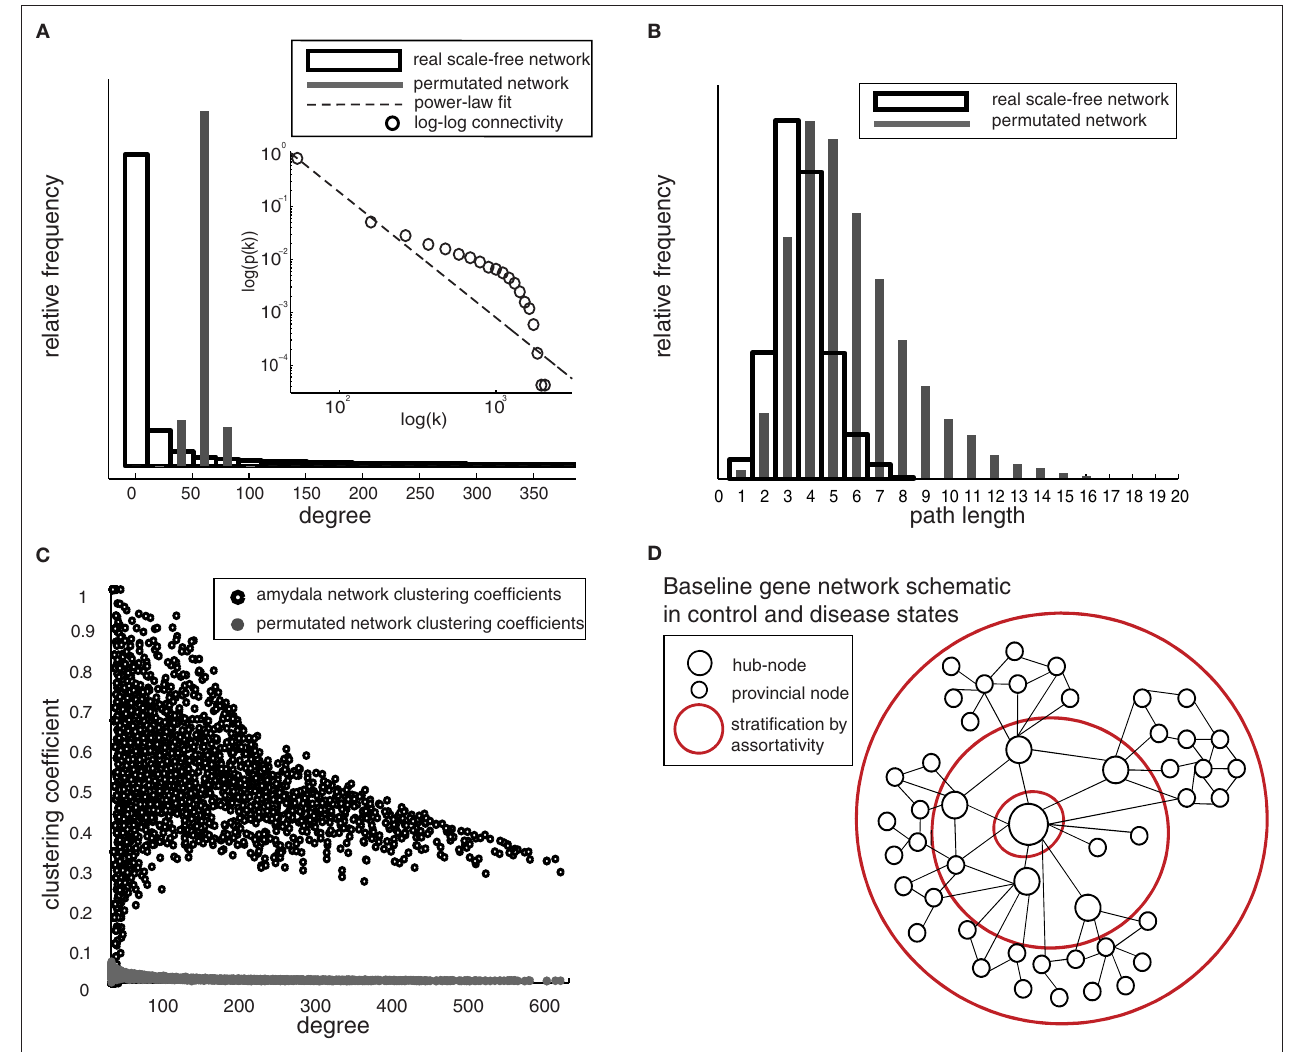
Figure 2 | Scale-free and small-world properties of gene networks common to all human brain datasets – examples from human amygdala. (A) Histogram of frequency of connectivity values for exemplar amygdala network and randomized network with equal total number of links (degree, k), truncated at k = 400 for clarity. Inset: a power-law fit of full connectivity distribution ( R = 0.82) on log–log scale indicates that the distribution of links is approximately scale-free. The connectivity distribution does not follow an exact power-law, but the degree distribution is highly heterogeneous compared to the Gaussian degree distribution expected under random connectivity (gray